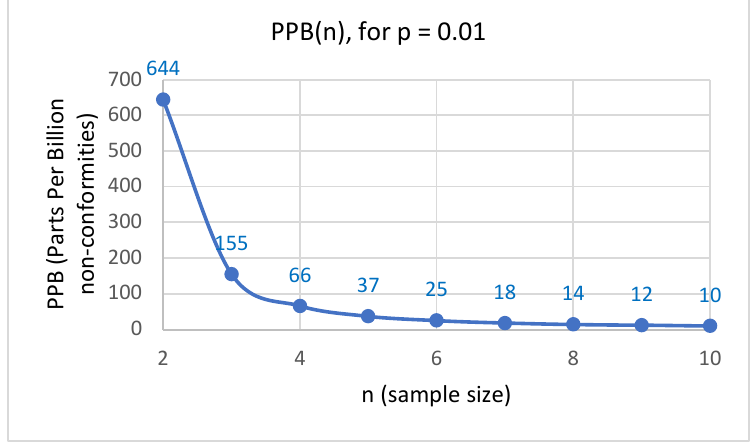
Figure 9. The graph PPB(n) for n = 2…10 and for step size p = 0.01.